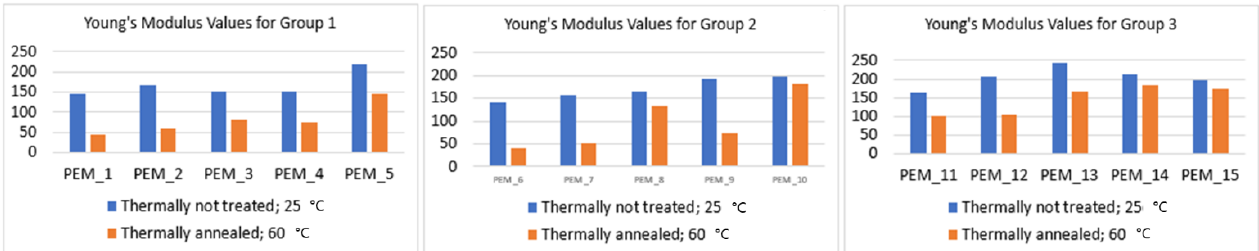
Figure 14. Comparison of thermally not treated and thermally annealed 15 membranes’ Young’s modulus values. In the literature, it is stated that for an undoped membrane, elongation values should be greater than 100% as a conservative metric [104]. In fact, all of the undoped and ther- mally untreated membranes exhibit elongation higher than 100%, except PEM_3, PEM_4, PEM_5, PEM_10, and PEM_15, where their elongation values were found to be lower than